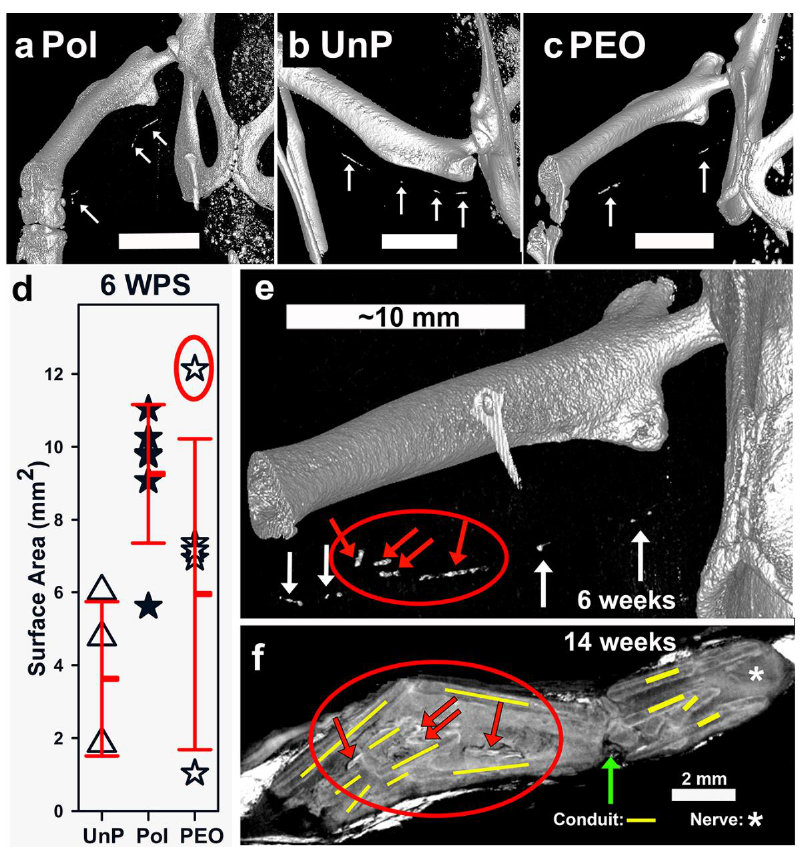
Figure 6. In vivo Mg filament degradation in nerve repair. ( a – c ) Live rat micro-CT 3D renderings at 6 weeks post-surgery (WPS), bars = 10 mm. ( d ) Live SA quantified at 6 WPS. ( e ) Live 6-week CT image of the rat with the largest SA, (red circle in ( d ) and red arrows inside the red circle show filament fragments off midline and semi-adjacent). ( f ) Micro-CT image at 14 WPS of tissues from same rat, with iodine contrast, showing degradation material in similar positions. Yellow bars illustrate broken conduit pieces. Asterisk ( * ) shows proximal nerve tissue and green upward arrow shows a significant break in conduit and tissues.